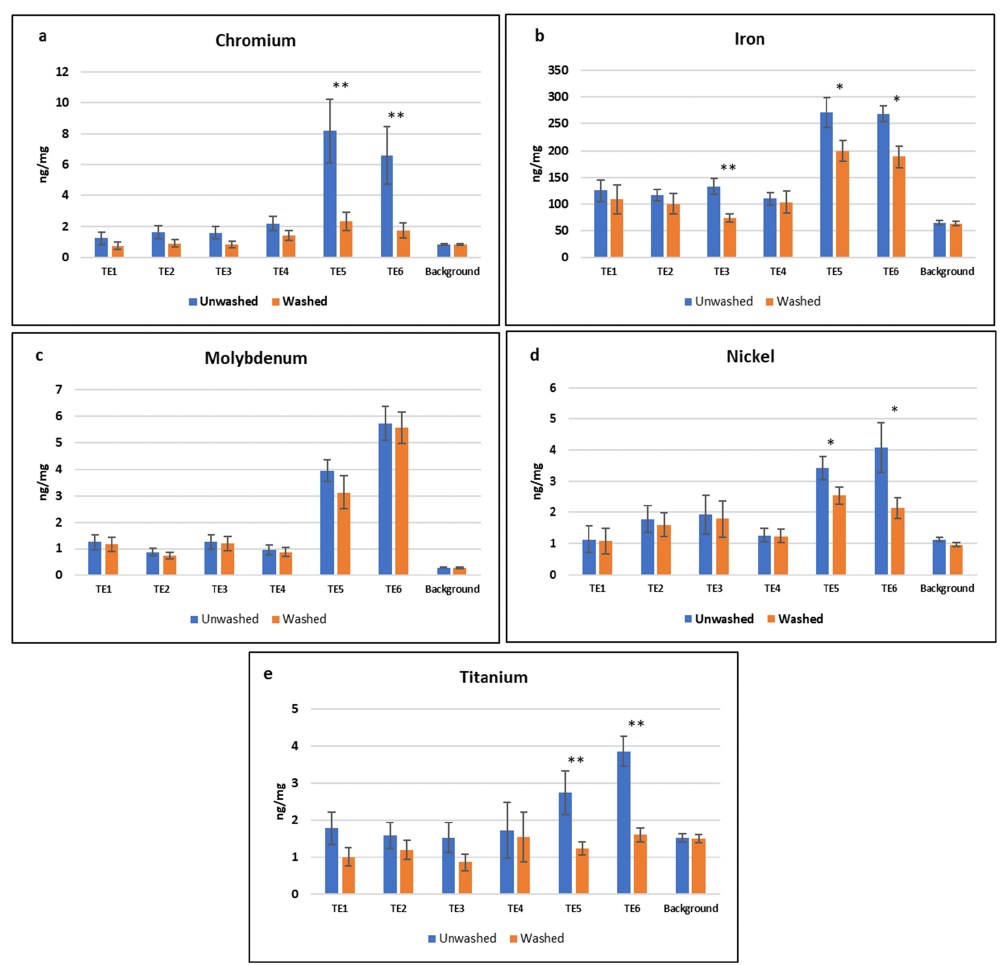
Figure 2. Comparison between averaged concentrations (ng mg − 1 ) of ( a ) Cr, ( b ) Fe, ( c ) Mo, ( d ) Ni, and ( e ) Ti detected in unwashed and washed leaves at the six sites: p -values obtained by applying paired sample t-test (* p < 0.05; ** p < 0.001) and standard deviations calculated between monthly concentrations are reported.